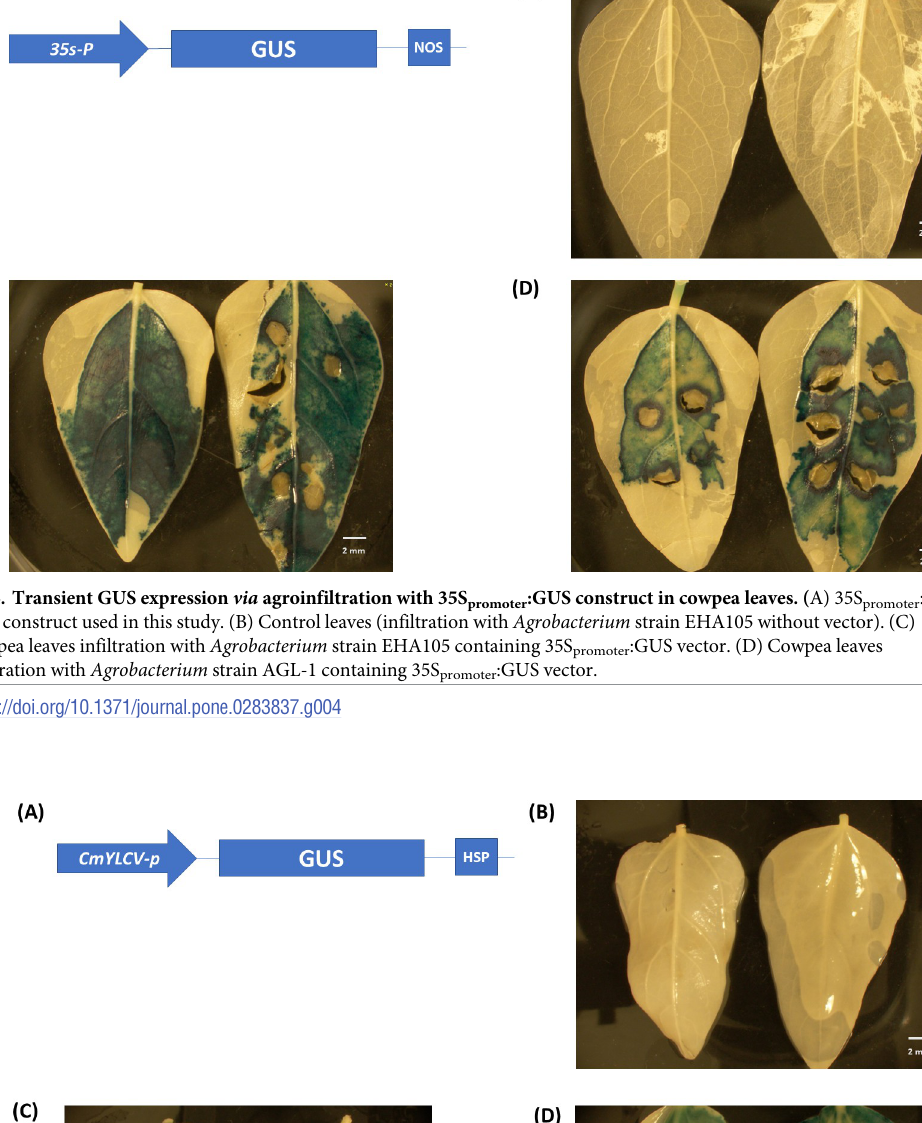
PLOS ONE | https://doi.org/10.1371/journal.pone.0283837 April 5,